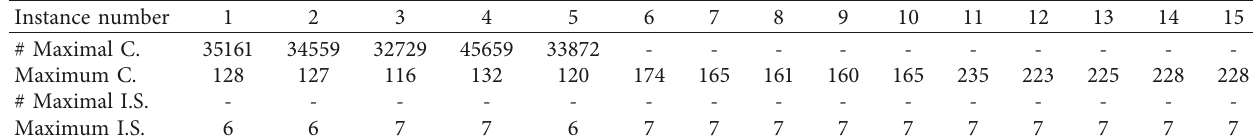
Table 10: Maximal cliques and maximal independent sets obtained with the Bron–Kerbosch algorithm for the instances #1–#15 in Table 9 using a radial coverage value of 0.2km. Instance number 1 2 # Maximal C. 2184 Maximum C. 30 # Maximal I.S. - - - - - - - - - - - Maximum I.S. 28 -, not solved in 2 hours.